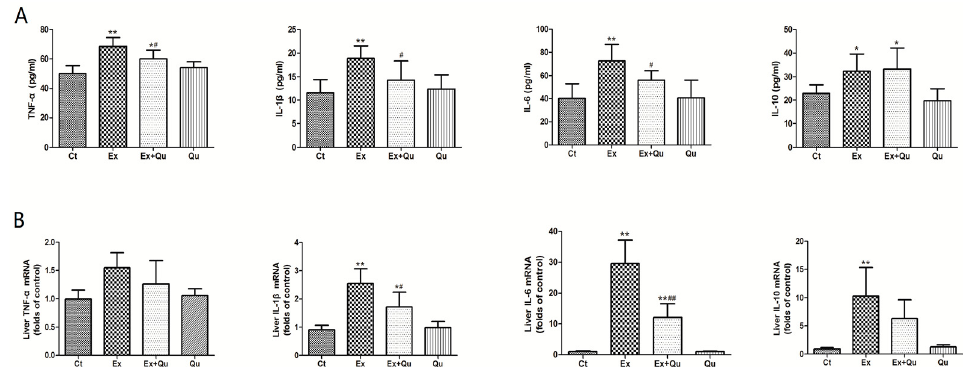
Figure 3. Serum and hepatic inflammatory cytokines levels of intensive exercise and/or quercetin prophylaxis. ( A ) Serum inflammatory cytokines were quantified by ELISA; results represented as mean ± SD ( n = 8); ( B ) liver TNF- α , IL-1 β , IL-6 and IL-10 levels evaluated by qRT-PCR; values presented as multiples of control following normalization by β -actin and mean ± SD ( n = 8). Ct—rested control; Ex—intensive exercise; Ex + Qu—Ex + quercetin; Qu—rested + quercetin. * p < 0.05, ** p < 0.01 vs. Ct; # p < 0.05, ## p < 0.01 vs. Ex.